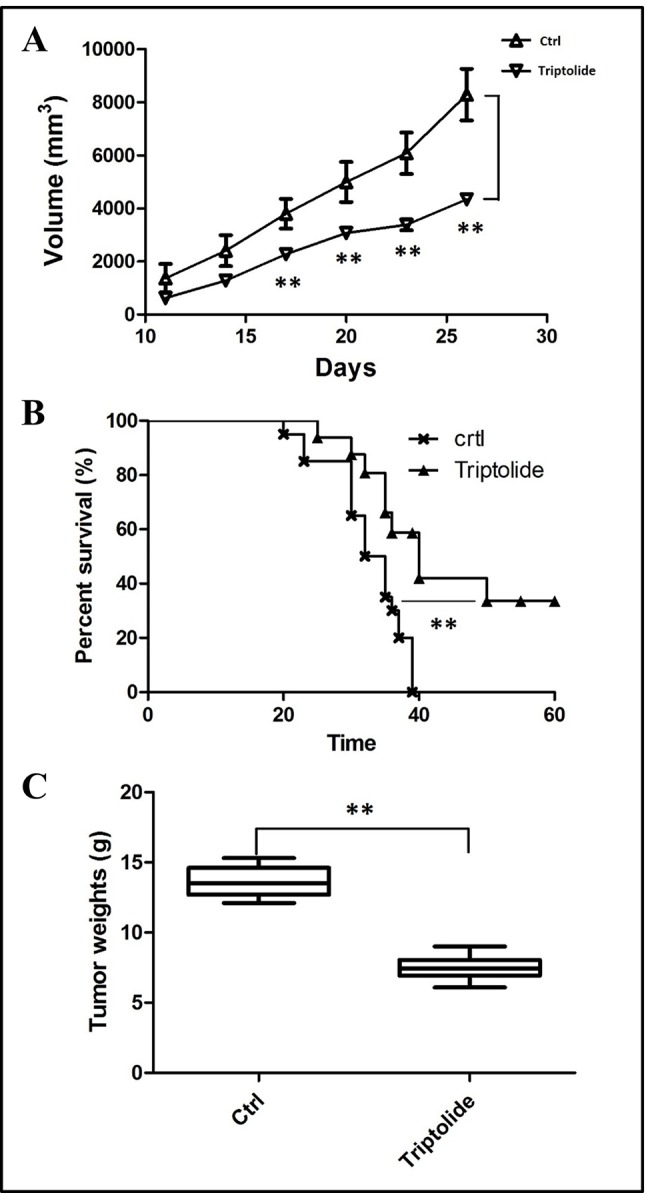
Tumor inhibitory effect of triptolide in a mouse CT26 tumor model. (A) tumor volumes were determined from the histograms at 5-day intervals after CT26 subcutaneous injection. (B) Percentage survival curves of tumor model and triptolide-treated groups. (C) Tumor weights (**P < 0.01, Triptolide vs. control group).